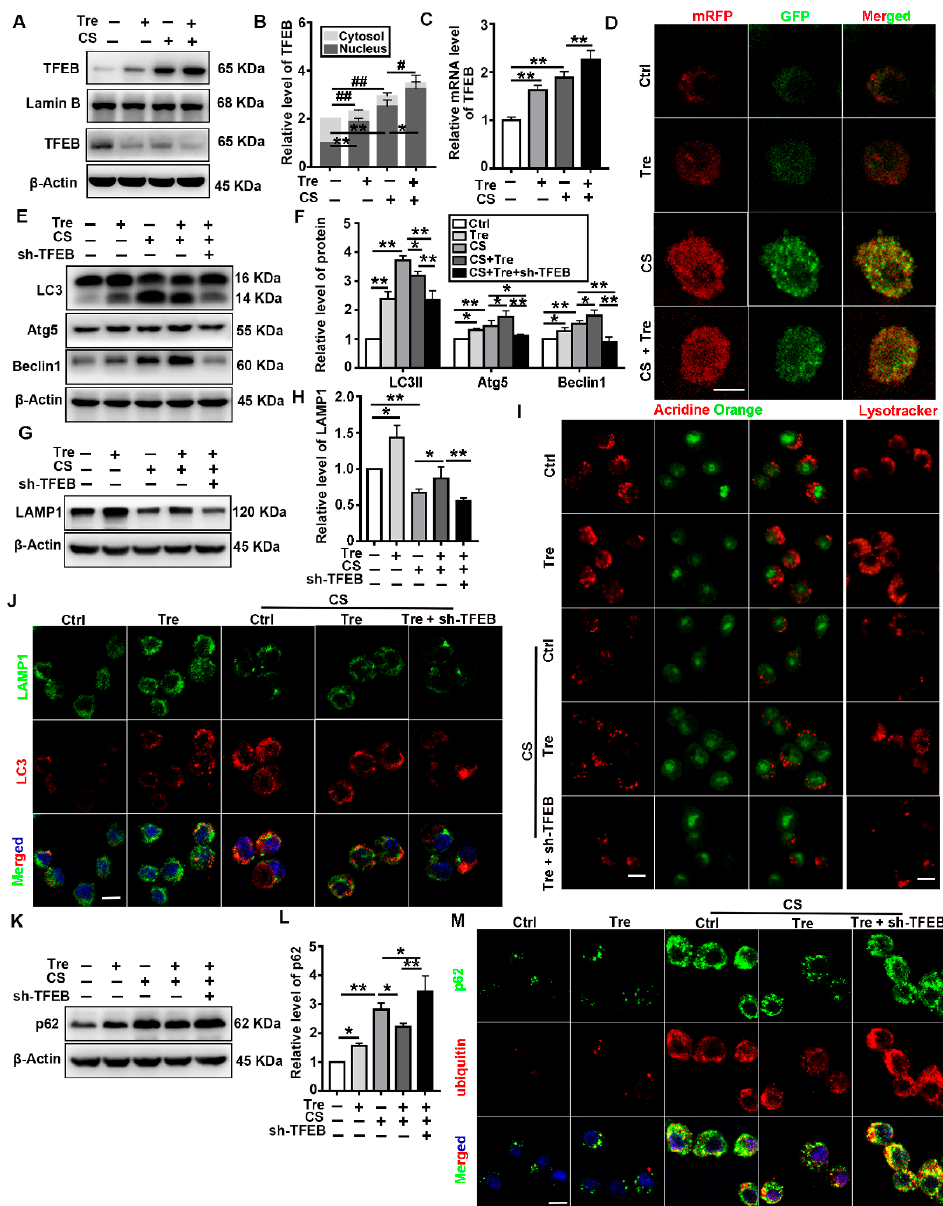
Figure 6. Tre relieves CS ‐ induced lysosome damage and restores autophagic substrate degradation through TFEB activation in vitro. ( A , B ) Immunoblotting analysis of TFEB levels in the cytosol and nucleus of MH ‐ S cells post CS and Tre treatment and β‐ actin, loading control for cytosolic proteins; LaminB, loading control for nuclear proteins ( n = 3 to 4). ( C ) qPCR analysis of TFEB expression in MH ‐ S cells 12 h post ‐ CS and Tre treatment ( n = 3 to 4). ( D ) MH ‐ S cells were transfected with the adenovirus mRFP ‐ GFP ‐ LC3 plasmid. LC3 puncta were observed by confocal microscopy (scale bar = 10 μ m and n = 3). ( E , F ) Immunoblotting analysis of LC3II, Atg5, and Beclin 1 protein levels ( n = 3). ( G , H ) Immunoblotting analysis of LAMP1 protein levels in cell lysates ( n = 4). ( I ) Cells were grown on coverslips and stained with Lysotracker Red or acridine orange 12 h post CS and Tre treatment (scale bar = 10 μ m and n = 3). ( J ) Immunofluorescence analysis of the colocalization of LAMP1 and LC3 12 h post CS and Tre treatment (scale bar = 25 μ and n = 3). ( K – M ) Immunoblotting analysis of p62 and immunofluorescence analysis of the colocalization of p62 and ubiquitin 12 h post CS and Tre treatment (scale bar = 25 μ m and n = 3). Data are presented as the mean ± SD. *, p < 0.05; **, p < 0.01; #, p < 0.05; and ##, p < 0.01.